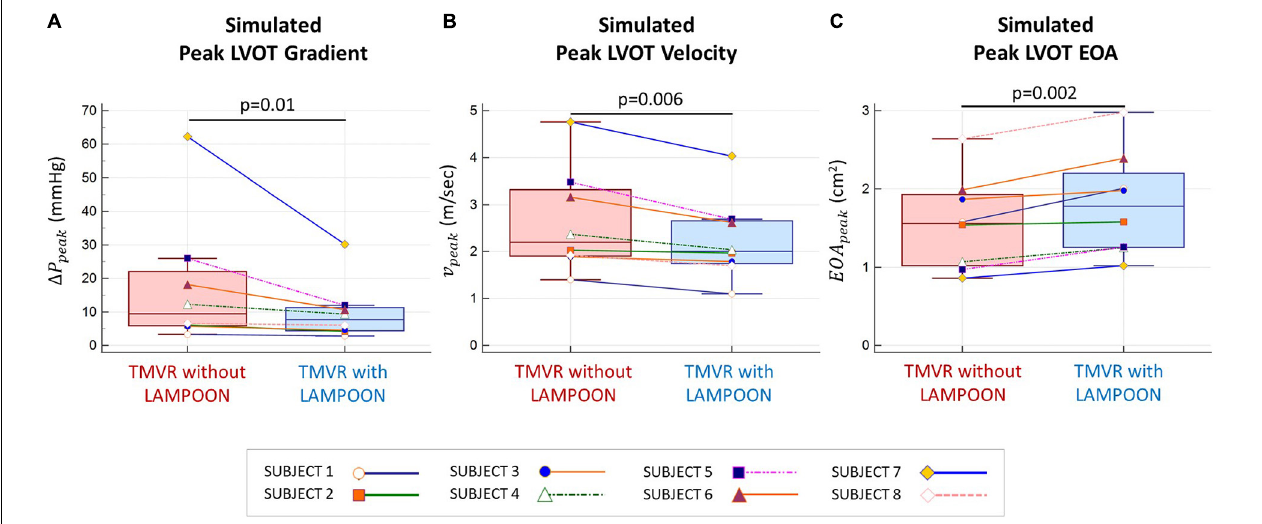
FIGURE 4 | Comparison of simulated hemodynamics following TMVR with and without LAMPOON. Simulated hemodynamics following TMVR with LAMPOON were superior to those following TMVR without LAMPOON for all subjects. Following LAMPOON, the simulated peak outflow gradient ( (cid:49) P peak ) and velocity ( v peak ) decreased in all subjects ( p < 0.05 for both comparisons) (A,B) . Additionally, the simulated peak effective orifice area ( EOA peak ) increased following LAMPOON in all subjects ( p < 0.05) (C) . LVOT, left ventricular outflow